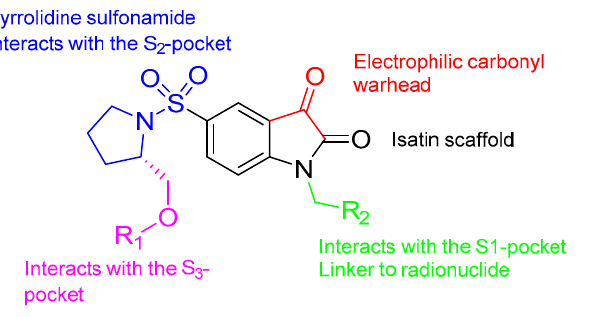
Table 1. Caspase-3 affinity of various isatin sulfonamide inhibitors and peptide-based ABPs, their relative selectivity and log P.